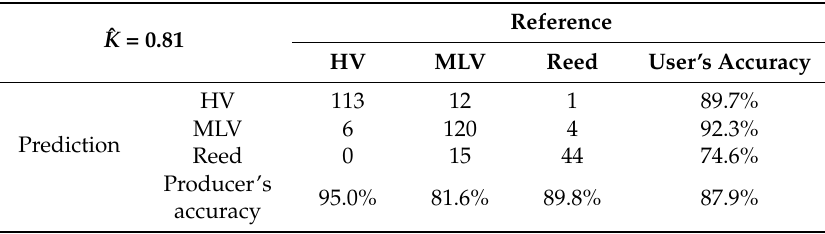
Table 7. Confusion matrix of the RF model using all of the bands, excluding NDVI (RF model 4). ˆ K = 0.87